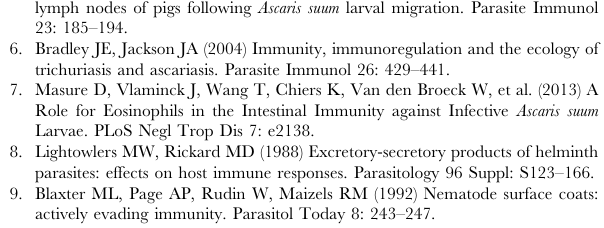
Table S1 Nucleotide sequences of the primers used in the qRT- PCR